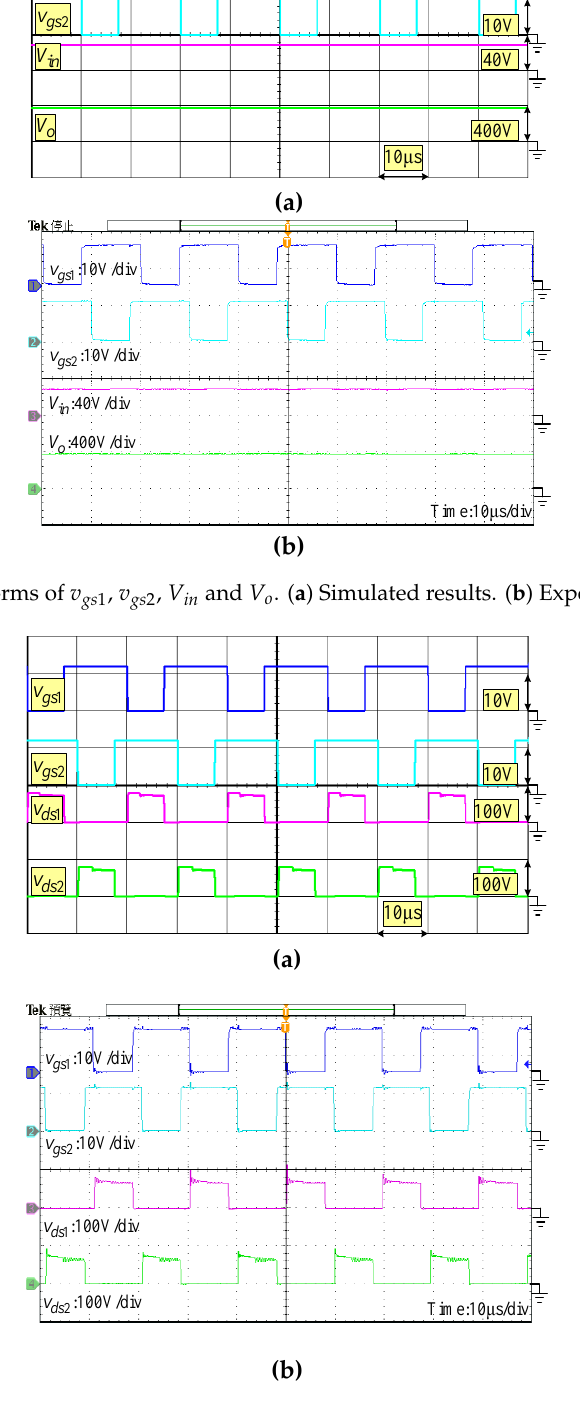
Figure 13. Waveforms of v gs 1 , v gs 2 , v ds 1 and v ds 2 . ( a ) Simulated results. ( b ) Experimental